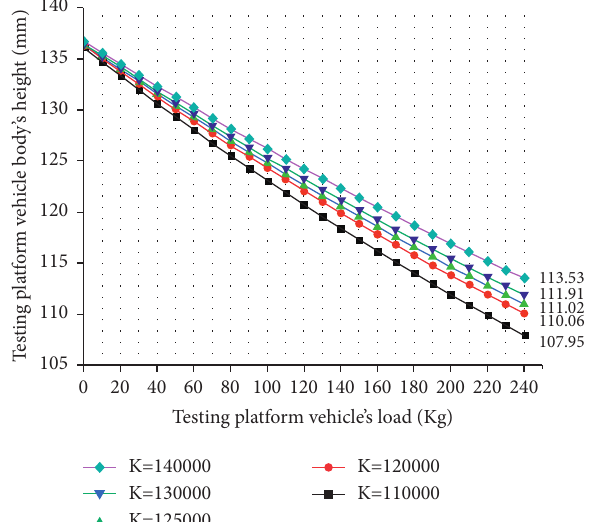
Figure 16: Sensitivity analysis results of the vehicle’s body height versus the loading conditions under different suspension